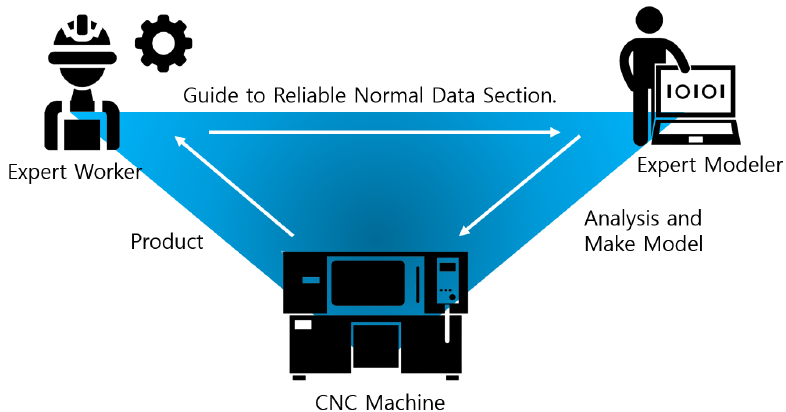
Figure 6. Normal data gathering method and Make model